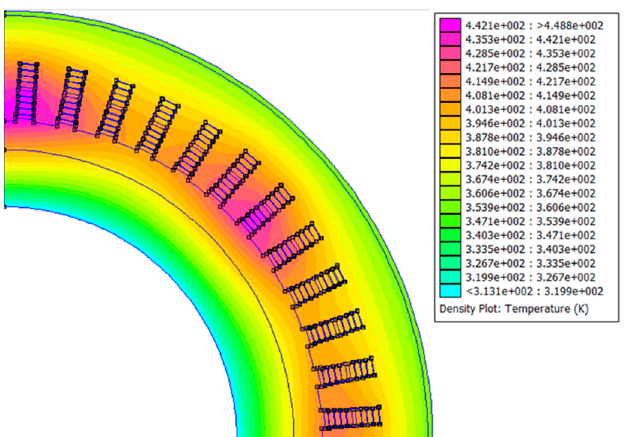
Figure 13. Temperature in the rear end-windings of the best power density motor ( upper figure ) and best rated power motor ( lower figure ).